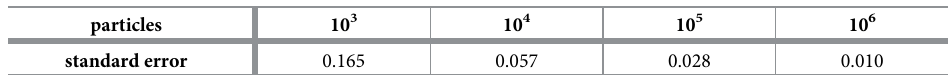
Table 1. Convergence of the posterior estimate of ^ R